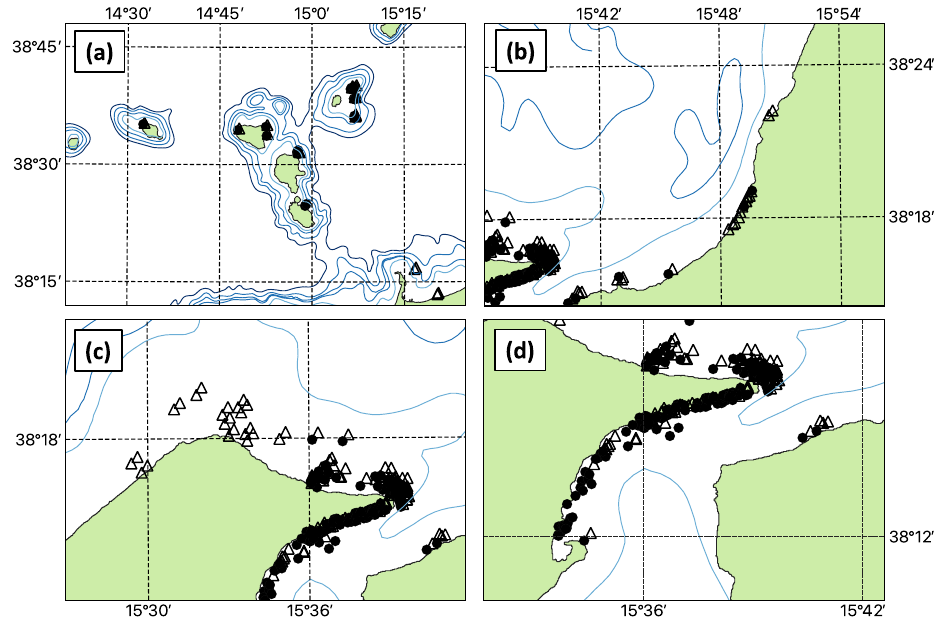
Figure 3. Visual observation effort in coastal and open waters sub-regions of the study area during March 2015–January 2016: ( a ) Aeolian Island Archipelago; ( b ) Calabrian coast; ( c ) Sicilian coast; ( d ) Messina Strait. Reported observations of Pelagia noctiluca in January–June (black dots) and July-December (empty triangles) are indicated. Maps were generated with QGIS v. 3.22.6-Białowieża (https:// qgis. org/ it/ site/) under GNU General Public License. Coordinate Reference System: EPSG:4326